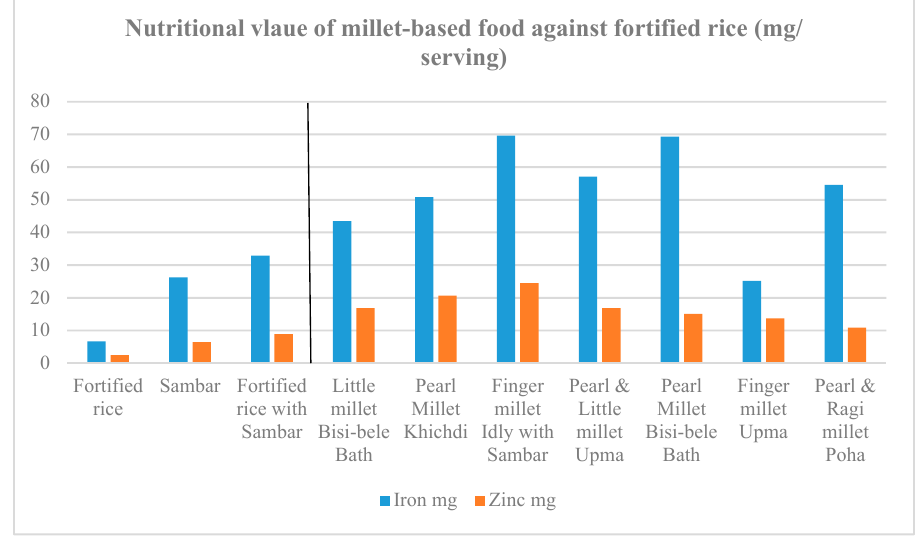
Figure 3. Energy content of the millet-based meals in comparison with a fortified rice-based meal.